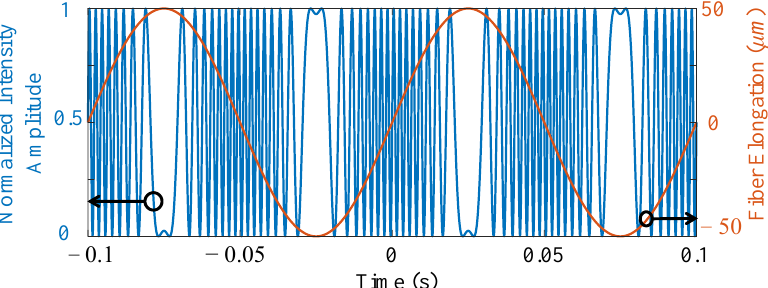
Figure 1. A comparison of the fluctuation frequency of the strain wave on the vibrating fiber Equation (3) and the optical intensity seen at the detector (4) for f = 10 Hz and ε · L = 5 × 10 − 5